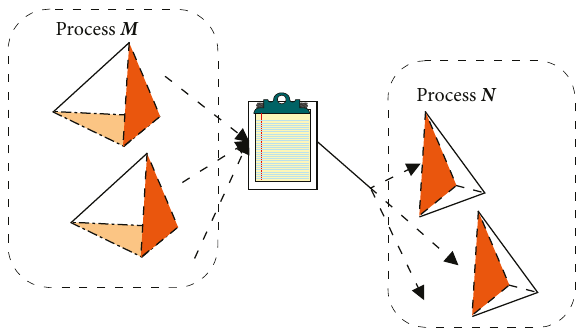
Figure 3: Data packaging and transmitting.